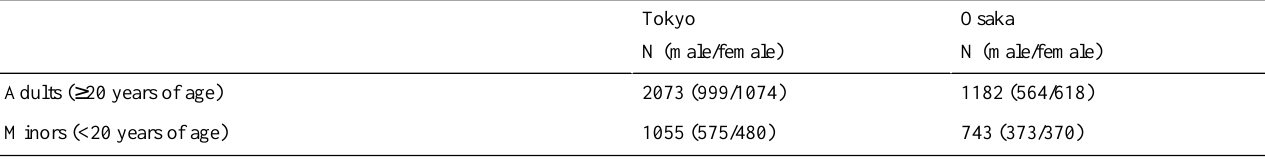
Table 1. Number of participants according to sex and age